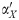
Association was detected in 19 out of 25 datasets with underlying association in the low Pearson correlation coefficient (<0.35) group: BPA for combinations of various αX′ and αY′ are shown as a heatmap for 9 datasets.Below every heatmap, a scatterplot of the actual data is shown. Also, a black line shows the relationship function that was calculated by curve fitting approaches. On the top left of the heatmap, the unique index of every dataset is presented. On the top of the heatmap Pearson correlation coefficient (PC) along with the p-value in brackets and the normalized mutual information content (MI) for the dataset is given. On the top of the scatterplot, the Spearman rank correlation coefficient (SR) and the Kendall tau rank correlation coefficient (KT) are given.